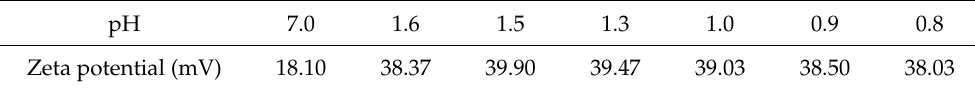
Table 2. Zeta potential of the GO@Fe 3 O 4 sol under various pH conditions.